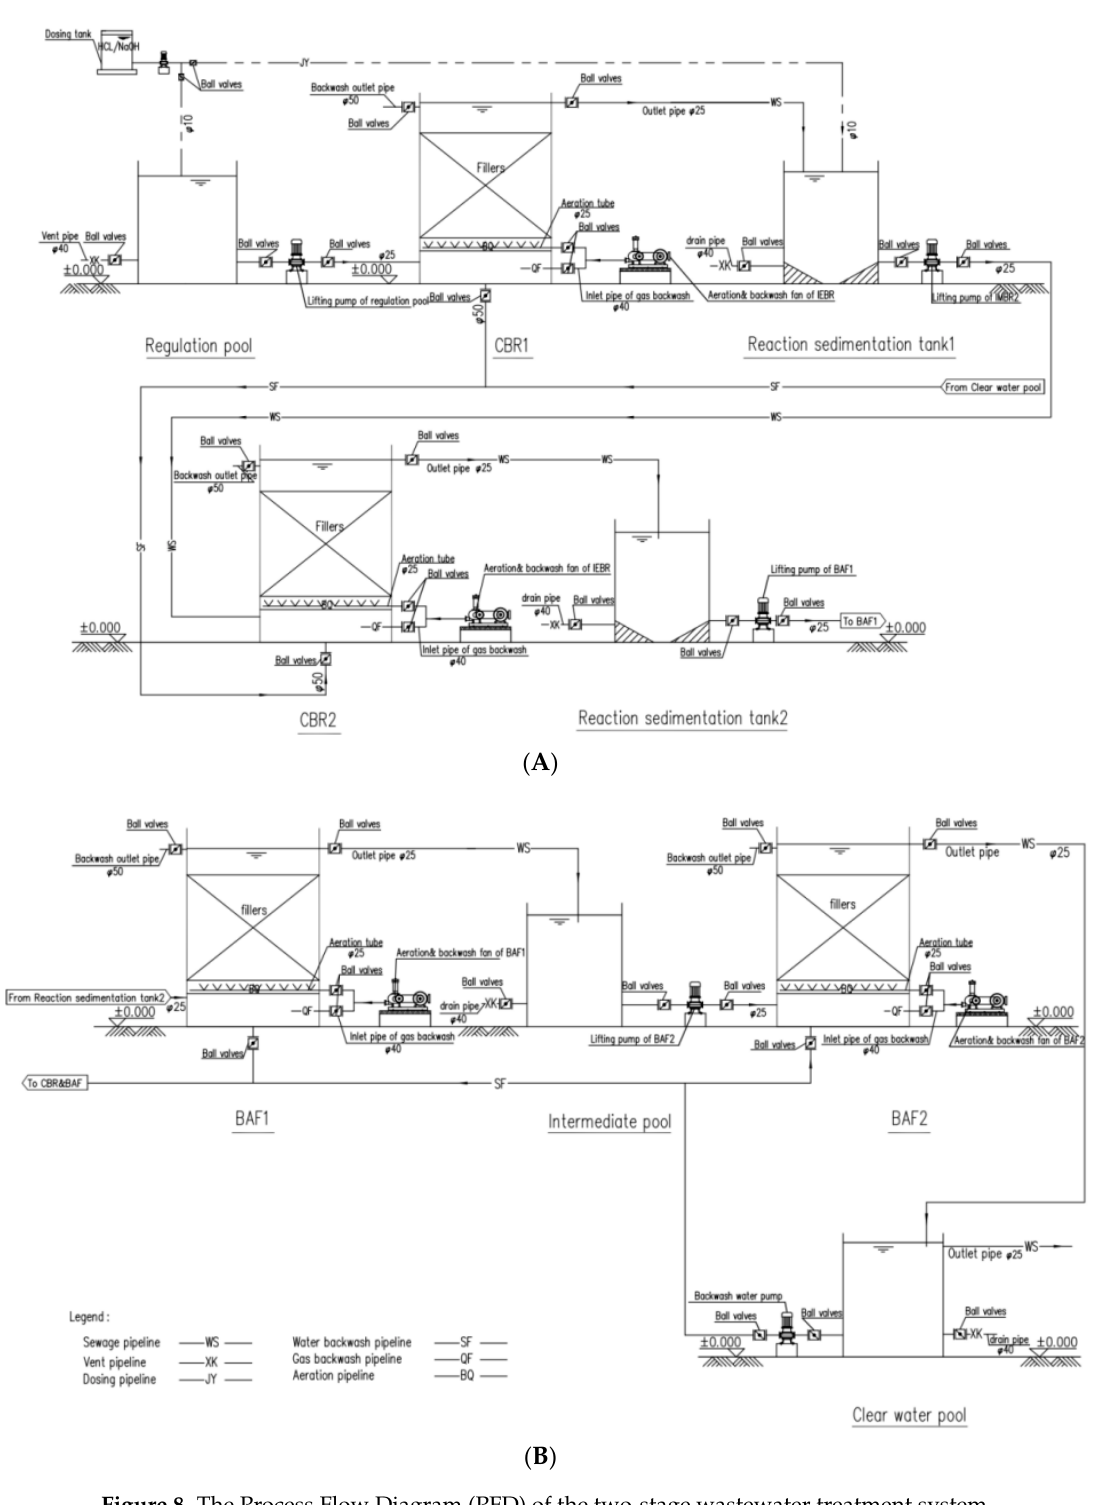
Figure 8. The Process Flow Diagram (PFD) of the two-stage wastewater treatment system.